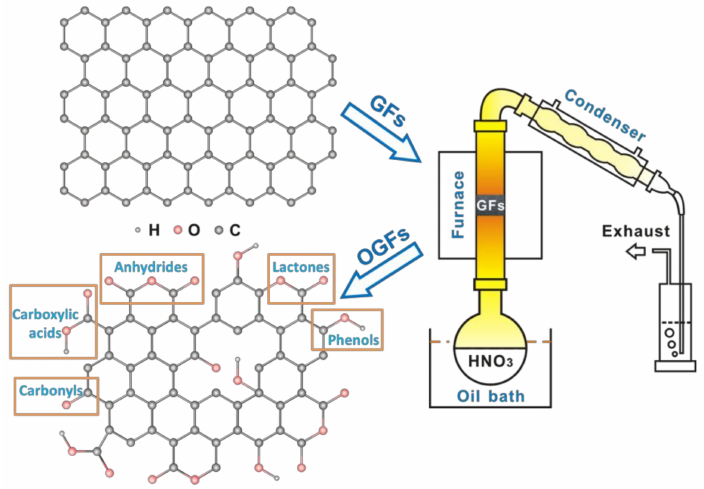
Figure 11. Schematic illustration of the OGFs prepared by the gaseous HNO 3 treatment and the different oxygenated functional groups generated on the graphite surface after the